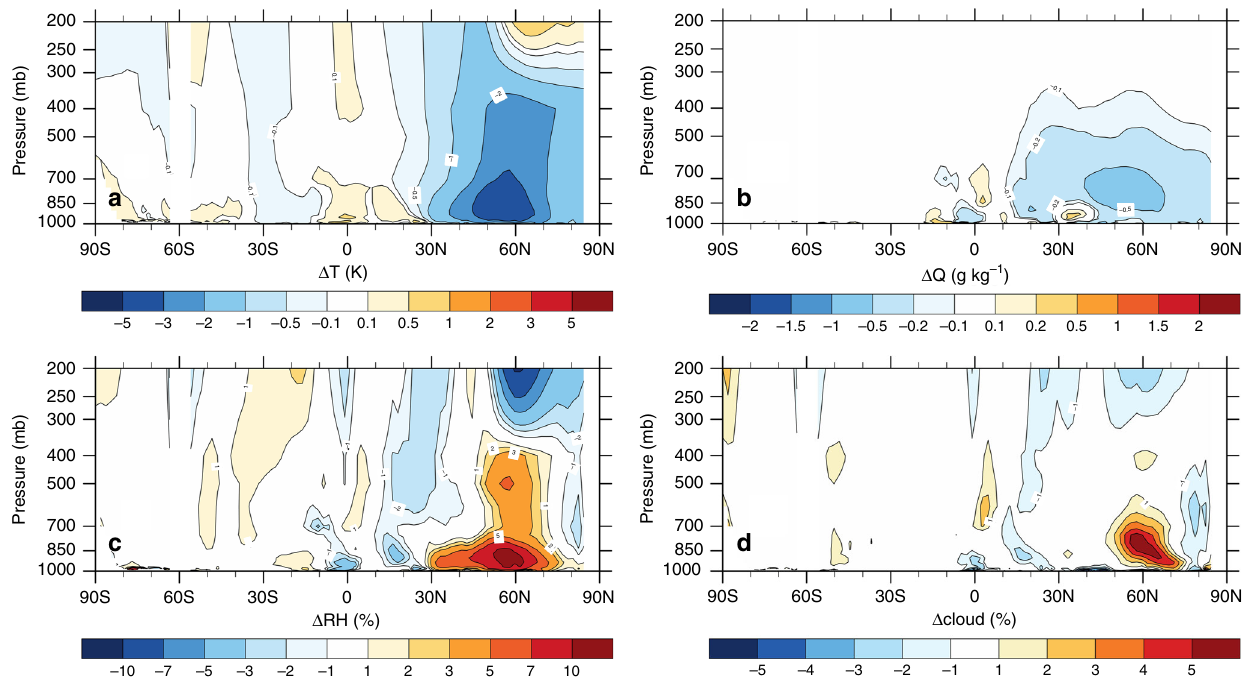
Fig. 3 Simulated impacts of deforestation on the atmosphere based on the coupled deforestation experiments. Changes in zonal-mean (land only) a temperature (T), b speci fi c humidity (Q), c relative humidity (RH), and d cloud cover after deforestation.